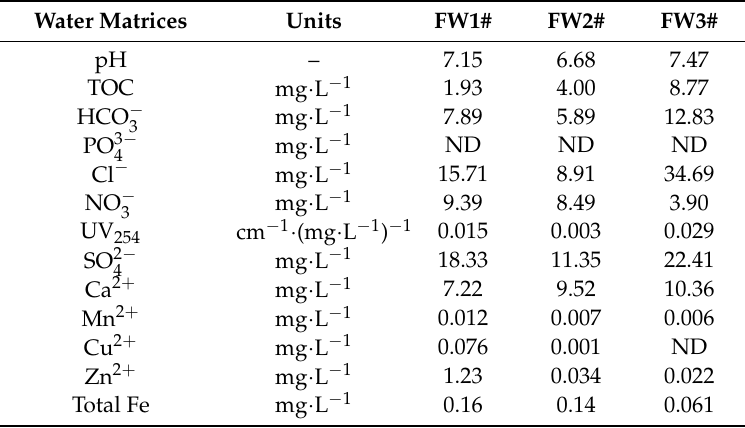
Table 2. Water quality of the waters collected from filtered water